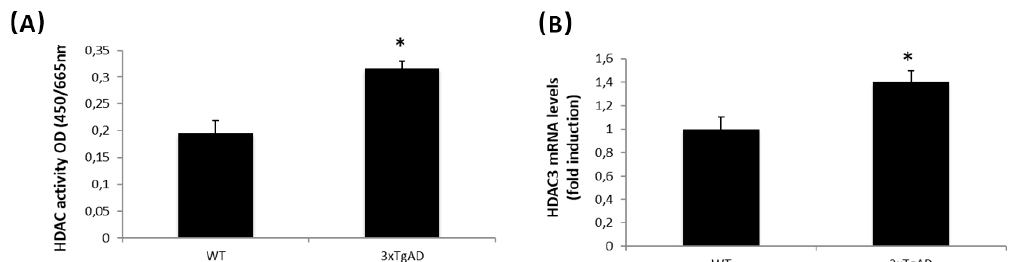
Figure 5. HDACs are regulated in APP/BIN1/COPS5 3xTg-AD mice. ( A ) HDAC activity was measured as indicated under Materials and Methods . ( B ) HDAC3 mRNA levels were measured by qPCR in samples from wild-type ( n = 4) and APP/BIN1/COPS5 3xTg-AD ( n = 4) mice. Data are expressed as mean ± S.E.M; * p <